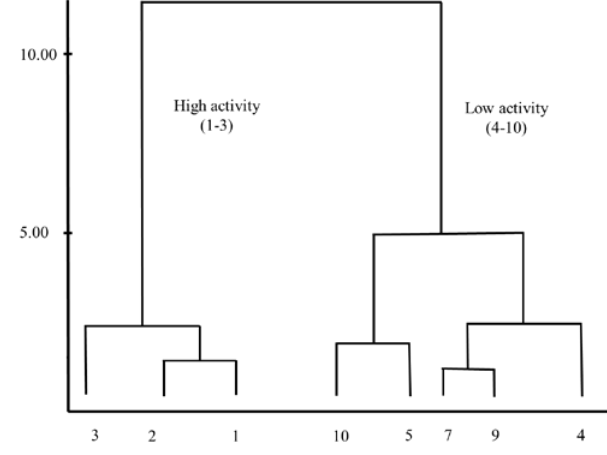
Figure 5. Dendrogram obtained from HCA of cytotoxicity of compounds from C. zedoaria